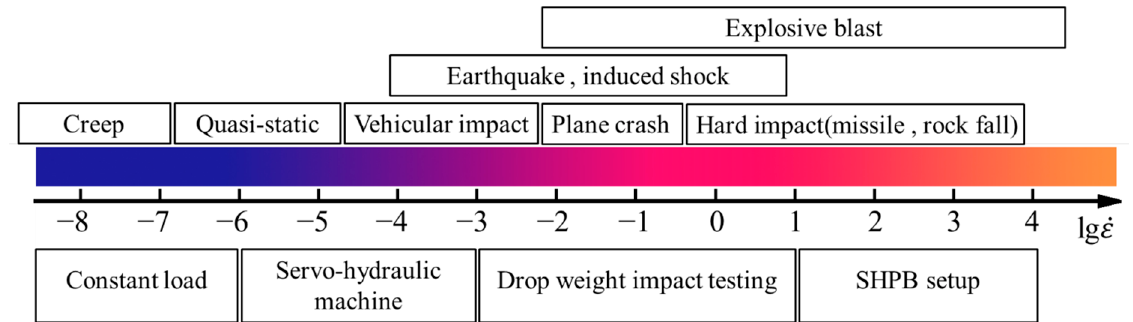
Figure 1. Typical strain rate range of concrete materials and the corresponding load cases.